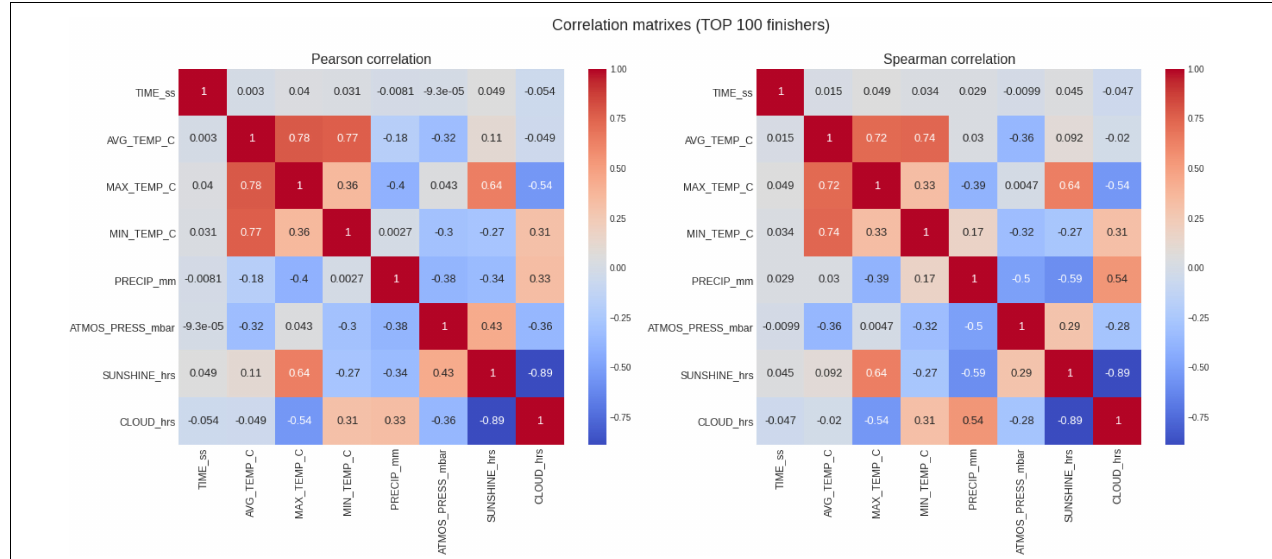
FIGURE 6 | Analysis of the correlation of the target variable (marathon race time) and the descriptive variables (weather conditions) for the top 100 runners. PRECIP, precipitation in mm; SUNSHINE duration in hours, CLOUD cover in hours; ATMOS_PRESS, atmospheric pressure in mbar; AVG_TEMP, average temperature in degrees Celsius; MAX_TEMP, maximum temperature in degrees Celsius; MN_TEMP, minimum temperature in degrees